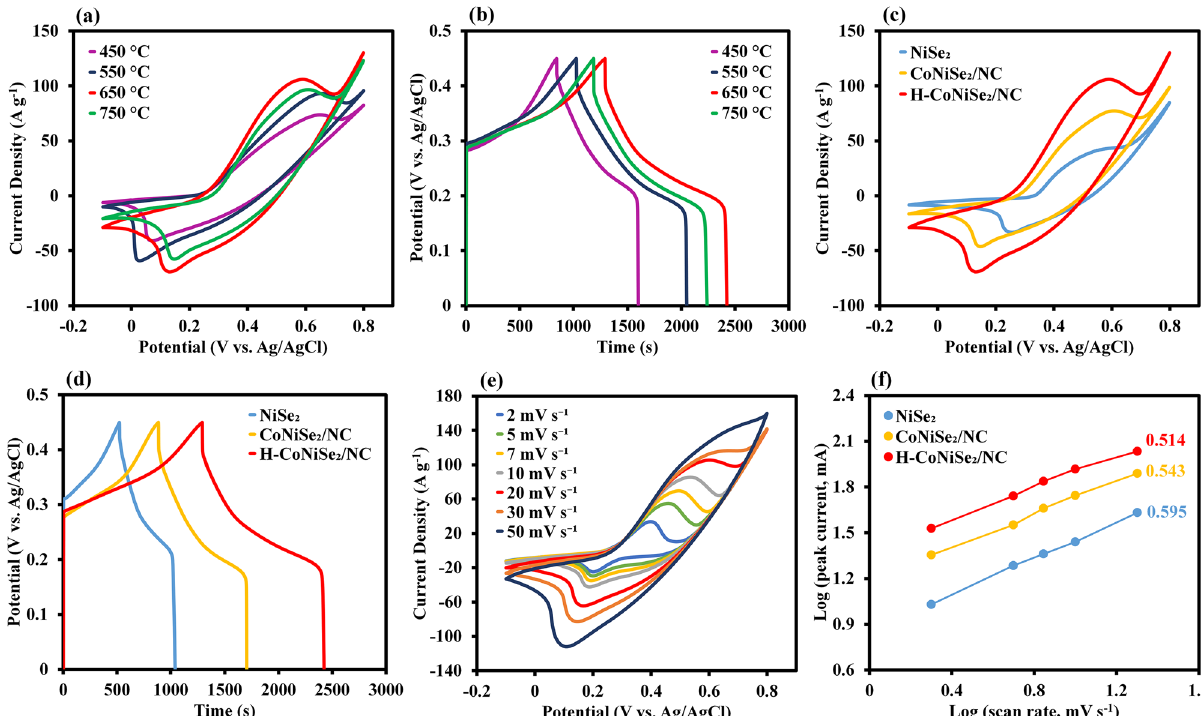
Figure 5. ( a ) CV curves of H-CoNiSe 2 /NC at 20 mV/s at different temperatures. ( b ) GCD curves of H-CoNiSe 2 /NC at 1 A/g at different temperatures. ( c ) CV curves of H-CoNiSe 2 /NC, CoNiSe 2 /NC, and NiSe 2 at 20 mV/s. ( d ) GCD curves of H-CoNiSe 2 /NC, CoNiSe 2 /NC, and NiSe 2 at 1 A/g. ( e ) CV curves of H-CoNiSe 2 /NC at various scan rates. ( f ) Log i − Log ν curves of H-CoNiSe 2 /NC, CoNiSe 2 /NC, and NiSe 2 (cathode